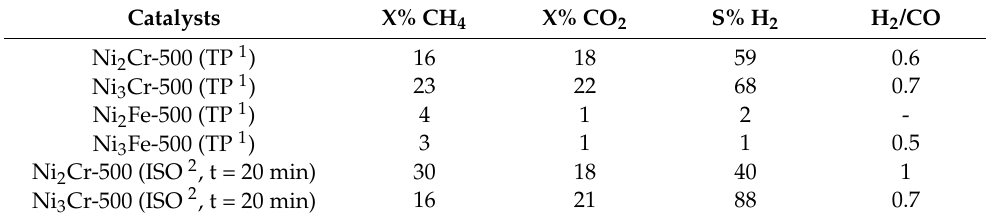
Table 5. DRM performances at 500 ◦ C in temperature-programmed and isothermal